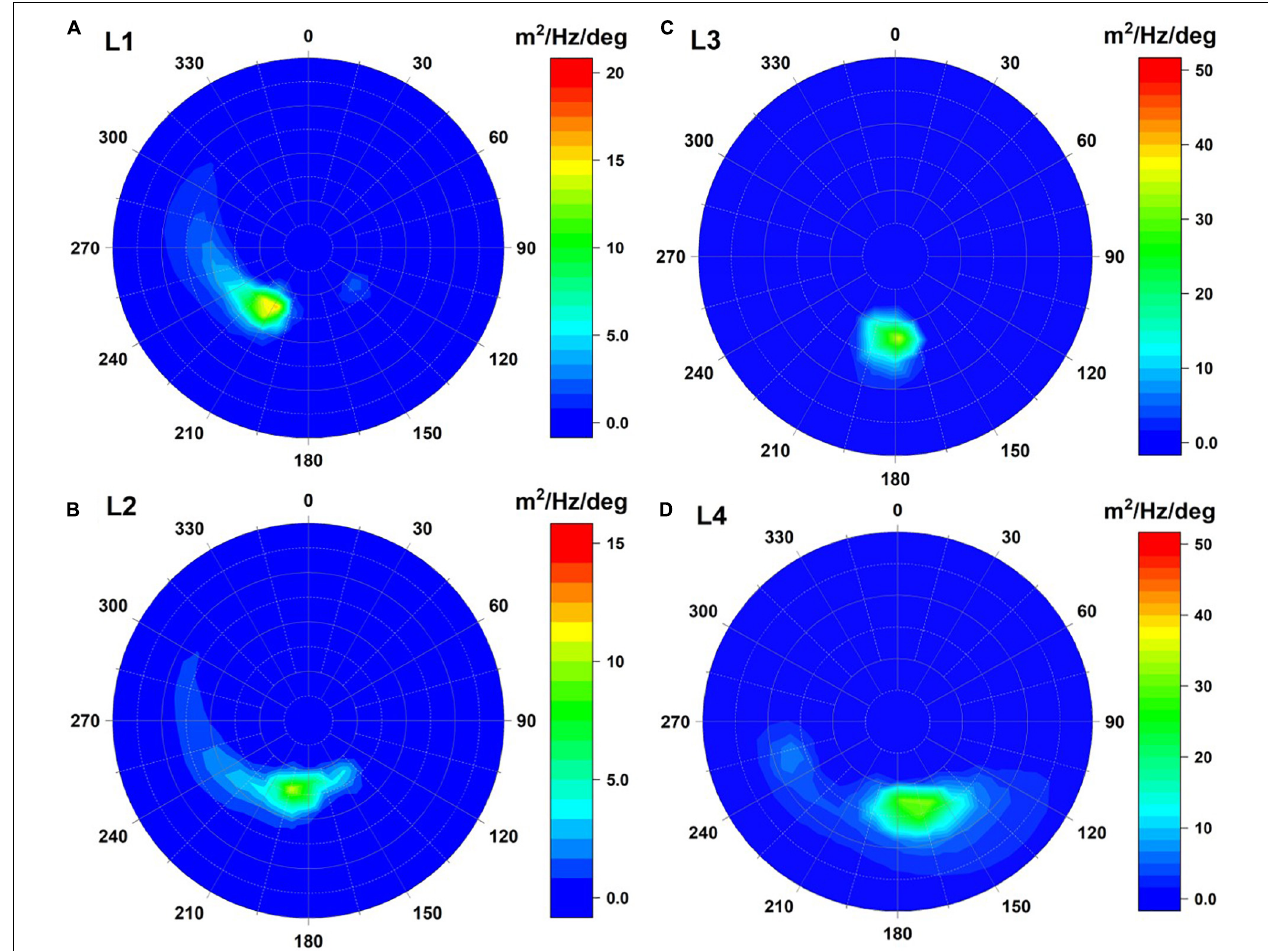
FIGURE 15 | Directional wave spectra generated by designed binary typhoons Lekima (2019) and Meranti (2016) at (A) L1, (B) L2, (C) L3, and (D) L4 four selected representative points at the time of the peak significant wave during single Super Typhoon Lekima (2019).